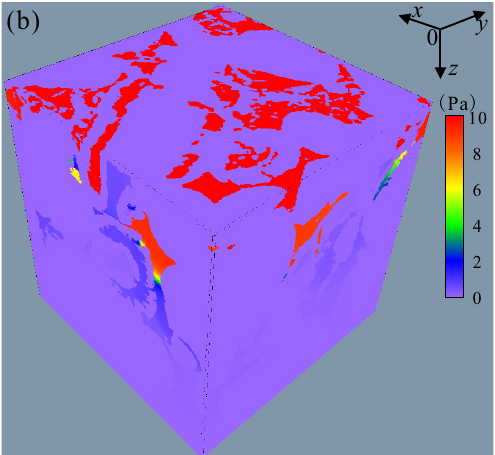
Figure 18. The distribution of coefficients wy and pressures of carbonate digital rock C1 at their original size. ( a ) The calculation results of coefficients wy for one-cell thick layer in direction of y . ( b ) The fluid pressure distribution of carbonate digital rock C1. The constant pressures at the inlet and outlet faces are 10 Pa and 0 Pa, respectively.